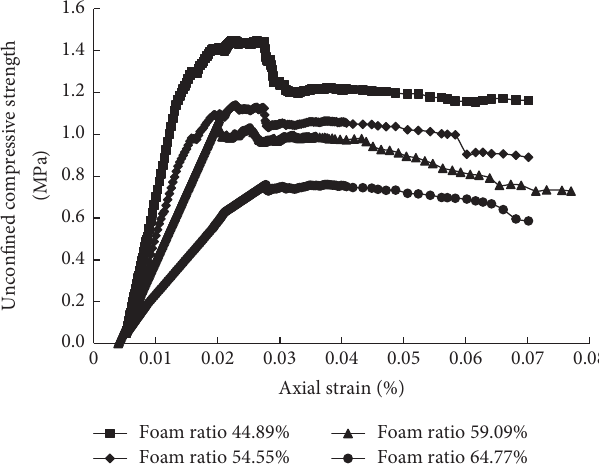
Figure 11: The stress-strain curves of FMLS with different rate of